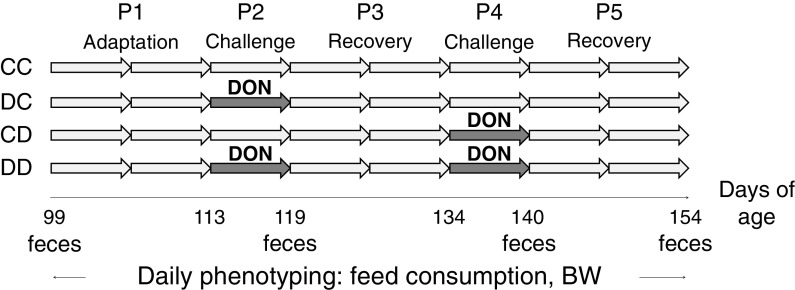
Experimental design. The pigs were given a control diet all over the experimental period (group CC) except for DC, CD and DD groups fed a deoxynivalenol- and zearalenone-contaminated diet (DON) during P2 (113 to 119 days), P4 (134 to 140 days) and both P2 and P4, respectively.